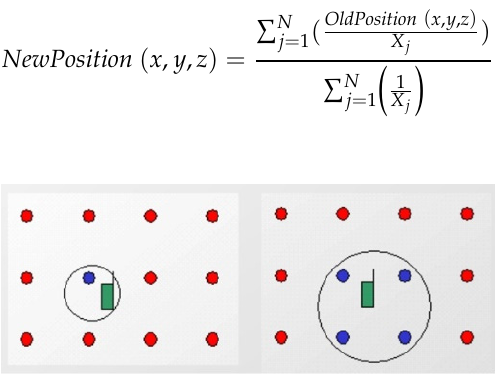
Figure 5. Interpolation technique implemented with four fingerprints.